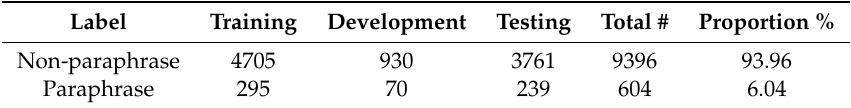
Table 4. New configuration of the ASSIN